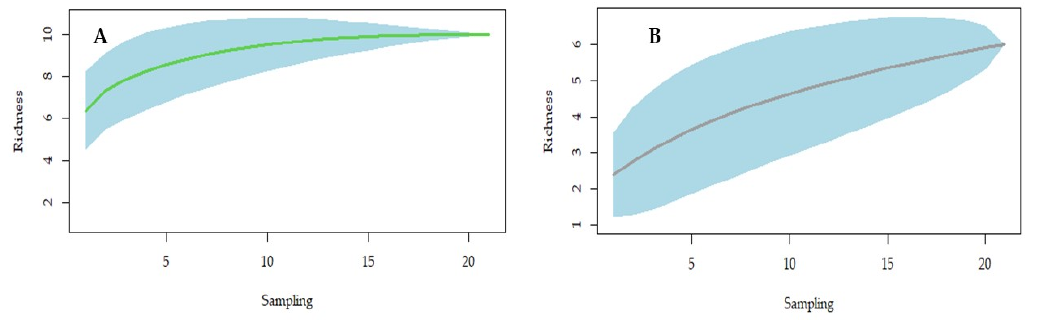
Figure 2. Rarefaction curves of sand flies in the forest areas ( A ) and the built areas ( B ) captured